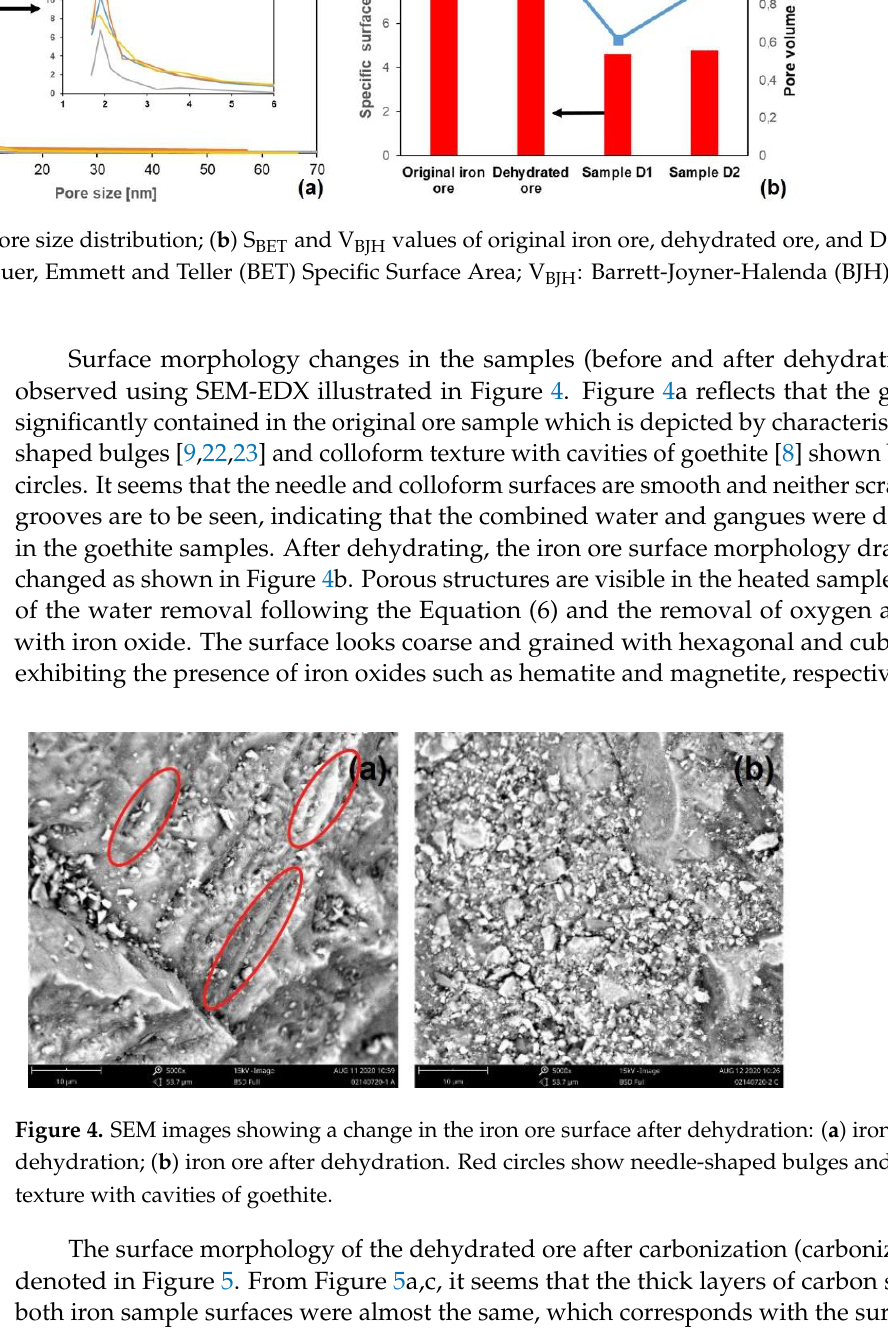
Figure 3. Changes in ( a ) pore size distribution; ( b ) S BET and V BJH values of original iron ore, dehy-